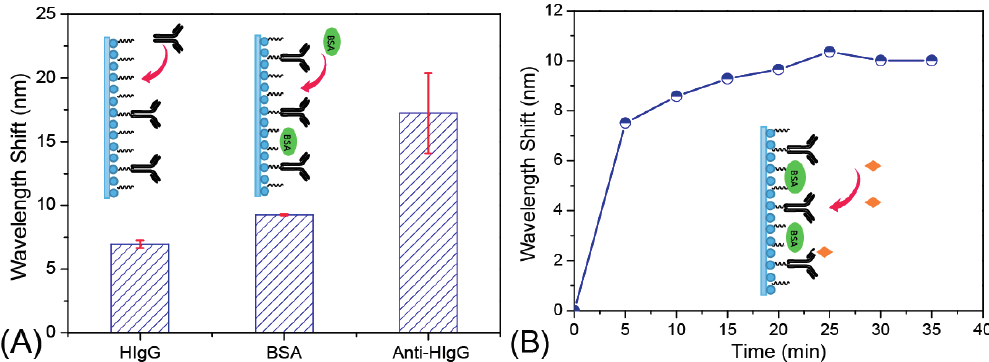
Figure 7. ( A ) Shifts of LSPR spectra of the Ag NP-based sensor after different stages of surface modification relative to the unmodified Ag NP sensor probe; ( B ) LSPR peak wavelength changes during the process of anti-human IgG immobilization on the Ag NP-based sensor surface over a period of 35